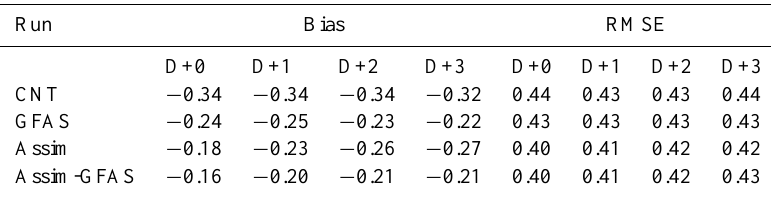
Table 12. Mean bias and RMSE of modeled tropospheric NO 2 columns (units 10 15 molec cm − 2 ), compared to OMI observations over western Russia between 20 July and 15 August, as function of the hindcast day. Run Bias